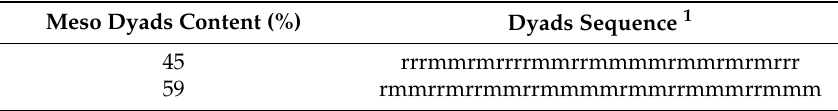
Table 3. Sequence of the racemo and meso dyads of the